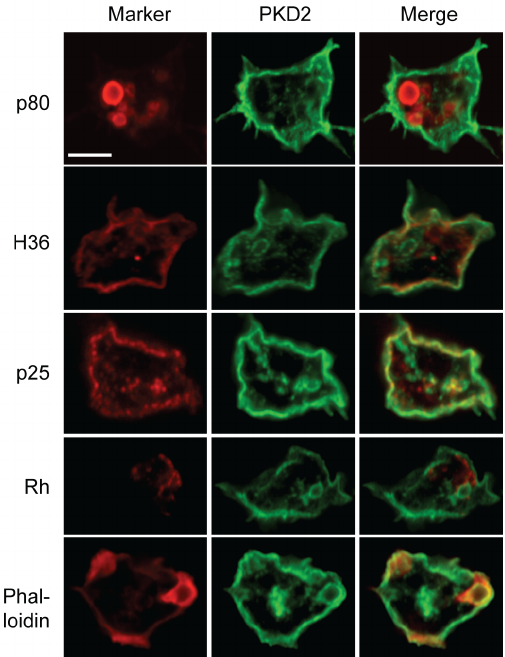
Figure 3. PKD2 localizes at the plasma membrane. Confocal images of PKD2-Flag transfected cells, labeled for the FLAG epitope (middle column, green) and cellular markers (left column, red) for late endosomes (p80), plasma membrane (H36), recycling endosomes (p25), contractile vacuole (Rh) and actin (phalloidin). Scale bar: 5 m m.